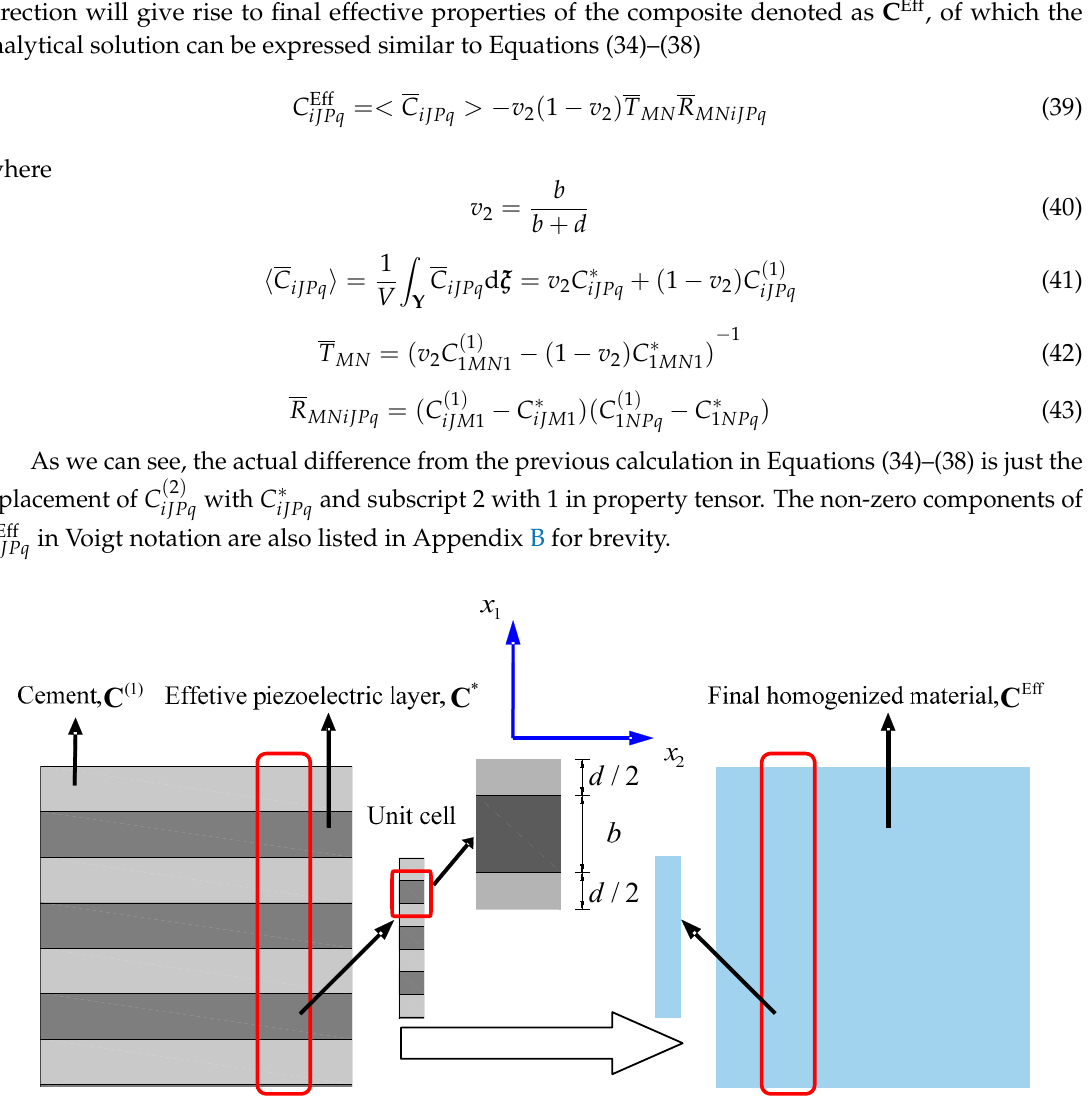
Figure 11. Second homogenization of the 1-3 type cement based piezoelectric composite.